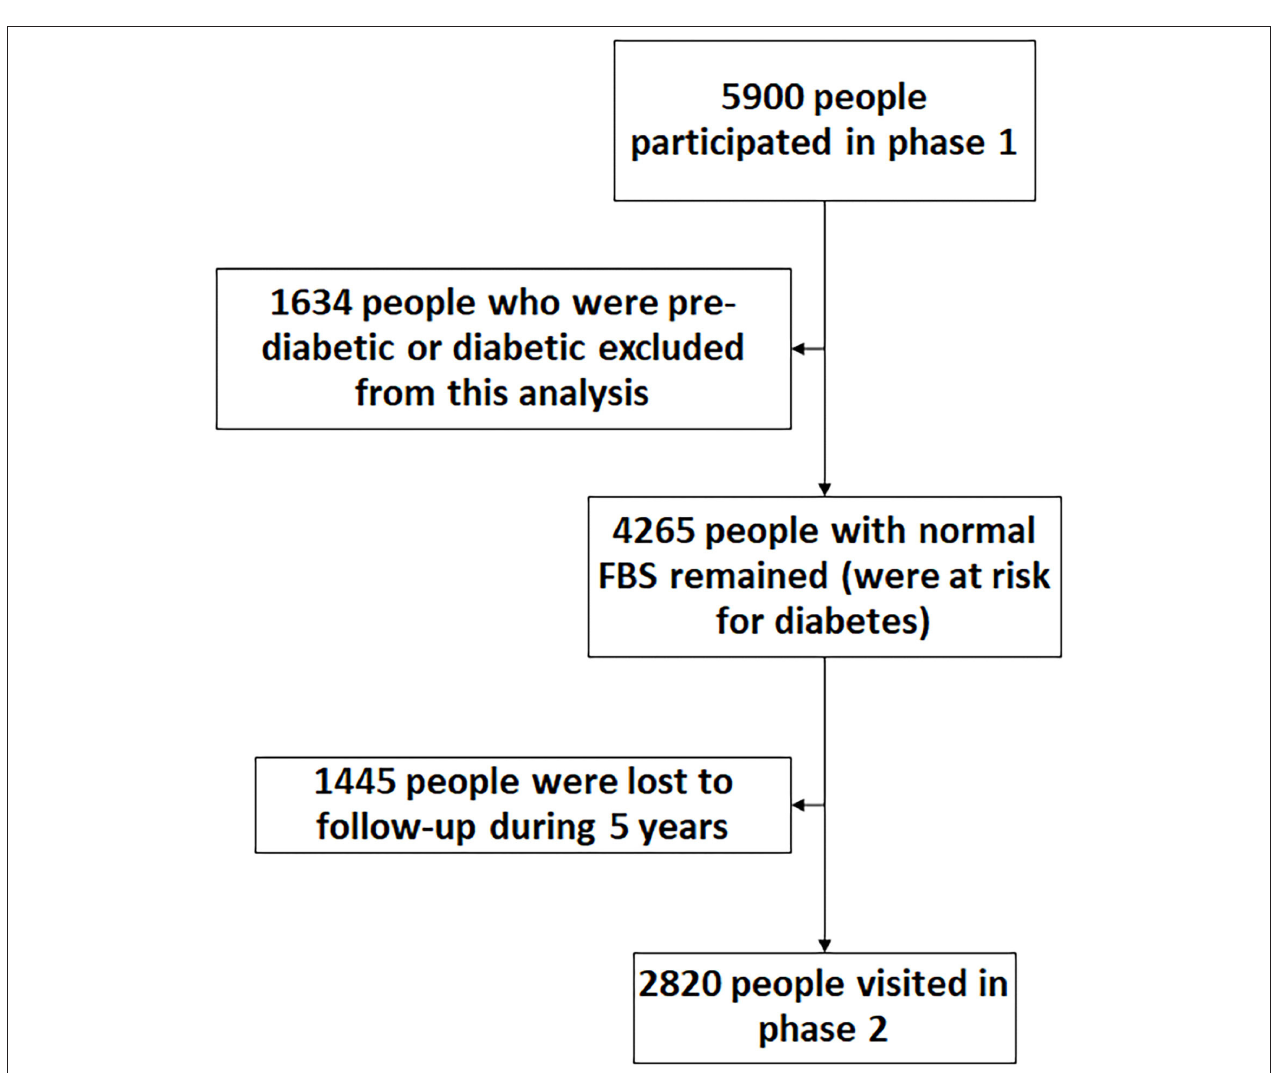
FIGURE 1 | The flow chart of people participated in both phases of the